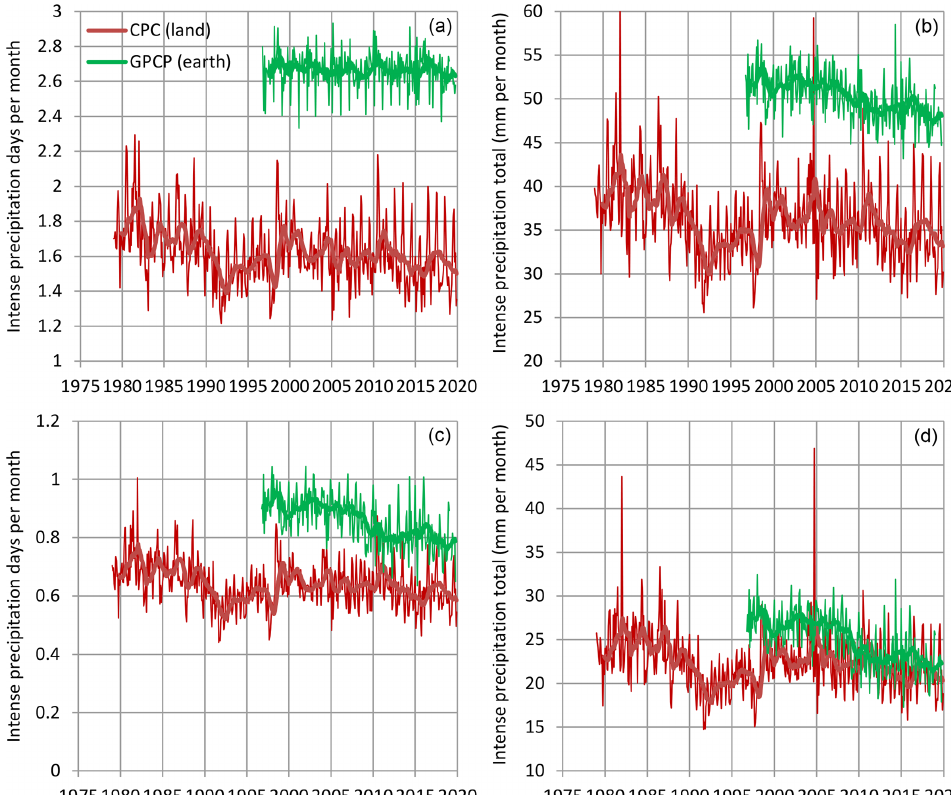
Figure B4. (a, c) Average days per month with precipitation exceeding a threshold value, which is 10mmd − 1 for the upper row and 20mmd − 1 for the lower row; (b, d) monthly total of daily precipitation exceeding the threshold value. Thin and thick lines of the same colour represent monthly values and running annual averages (right aligned), respectively. Sources of the data are indicated in the legend and detailed in Table 1.